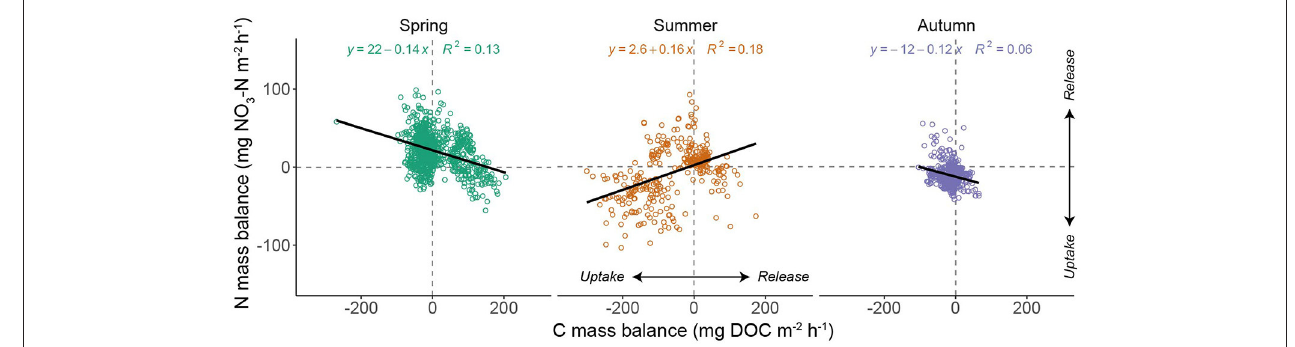
FIGURE 8 | Scatterplot of NO − 3 -N and DOC mass balance by season. Values of nutrient uptake < 0 indicate net removal from the water column. The thick black lines indicates the season-specific linear regression fit.